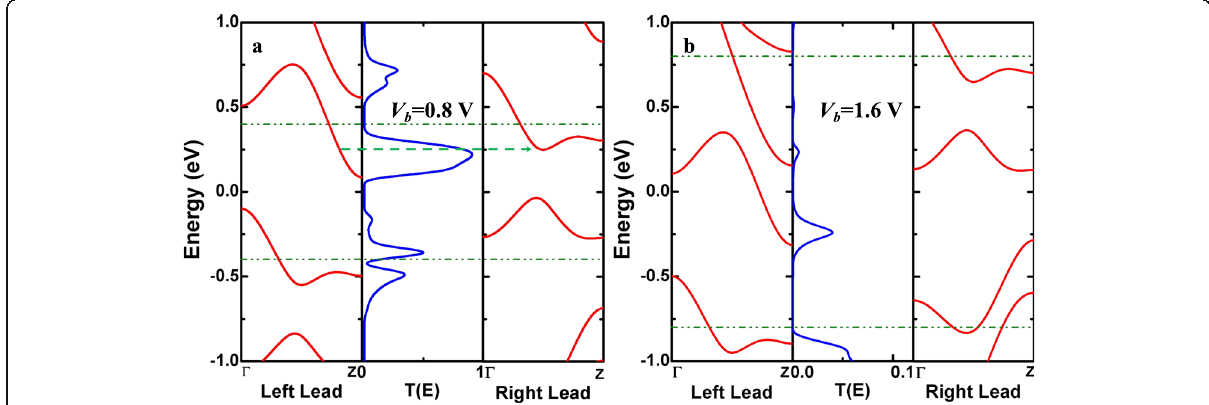
Fig. 8 (Color online) The spin-up band structures of the left/right leads and the spin-up transmission spectra of A γ GYNRs with double N-doping for M 6D under the biases of a 0.8 V and b 1.6 V. The region between the double horizontal green dashed lines is the corresponding bias window. For clarity, the maximum of transmission spectra in b is set to